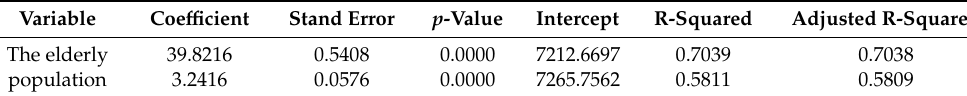
Table 2. OLS diagnostics.